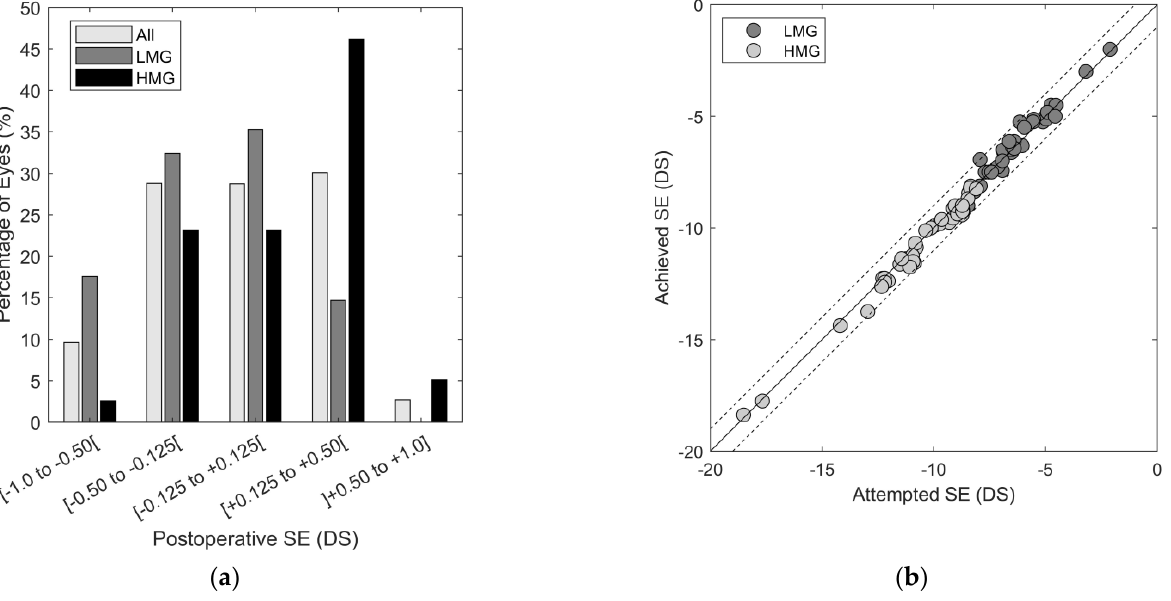
Figure 2. ( a ) Postoperative refraction distribution for all cases, in LMG and HMG groups. ( b ) Association between attempted and achieved SE. Continuous lines and dashed lines represent respectively the unitary relation and ± 0.50 DS of difference between attempted and achieved SE.